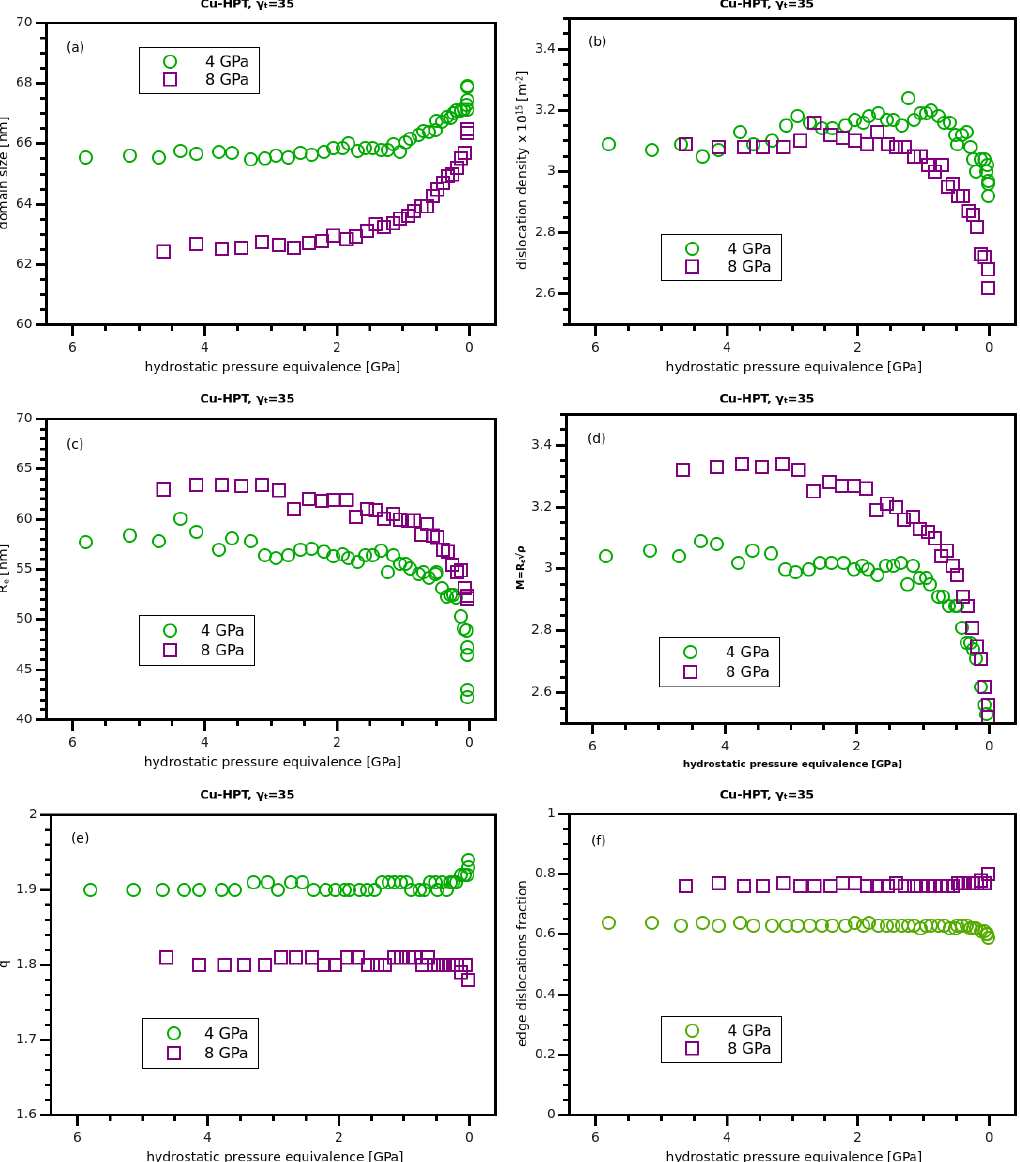
Figure 4. The evolution of the microstructural parameters for copper after HPT deformation at 4 and 8 GPa as obtained by the CMWP fit: the coherently scattering domain size ( a ); the dislocation density ( b ); the outer cut-off radius of the strain field of dislocations ( c ); the M -parameter as a measure of the mutual strain field screening of dislocations ( d ); the contrast parameter q ( e ); the fraction of edge dislocations as determined from q ( f